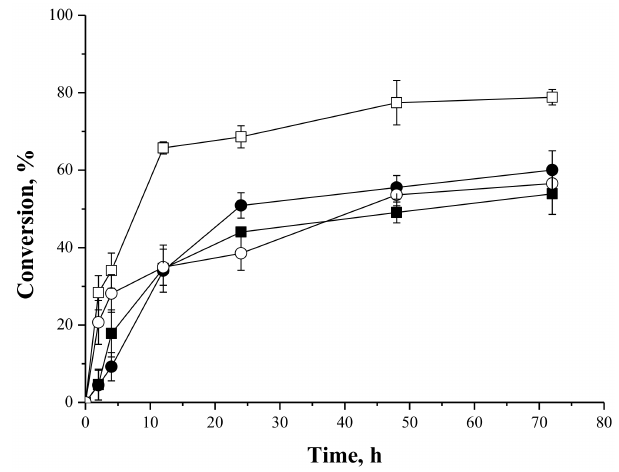
Figure 4. Oleic acid conversion as a function of time for syntheses of fructose oleate at 45 ◦ C, 250 rpm stirring, oleic acid and fructose initial concentrations of 25 mM, using IMMCALB-T2-350 ( (cid:3) ) and PFL-octyl-silica ( ) in the presence of tert -butyl alcohol and IMMCALB-T2-350 ( (cid:4) ) and PFL-octyl-silica (cid:35) ( ) in the presence of tert -amyl alcohol. For all assays 0.5 g of biocatalyst and 1.5 g of molecular sieves were